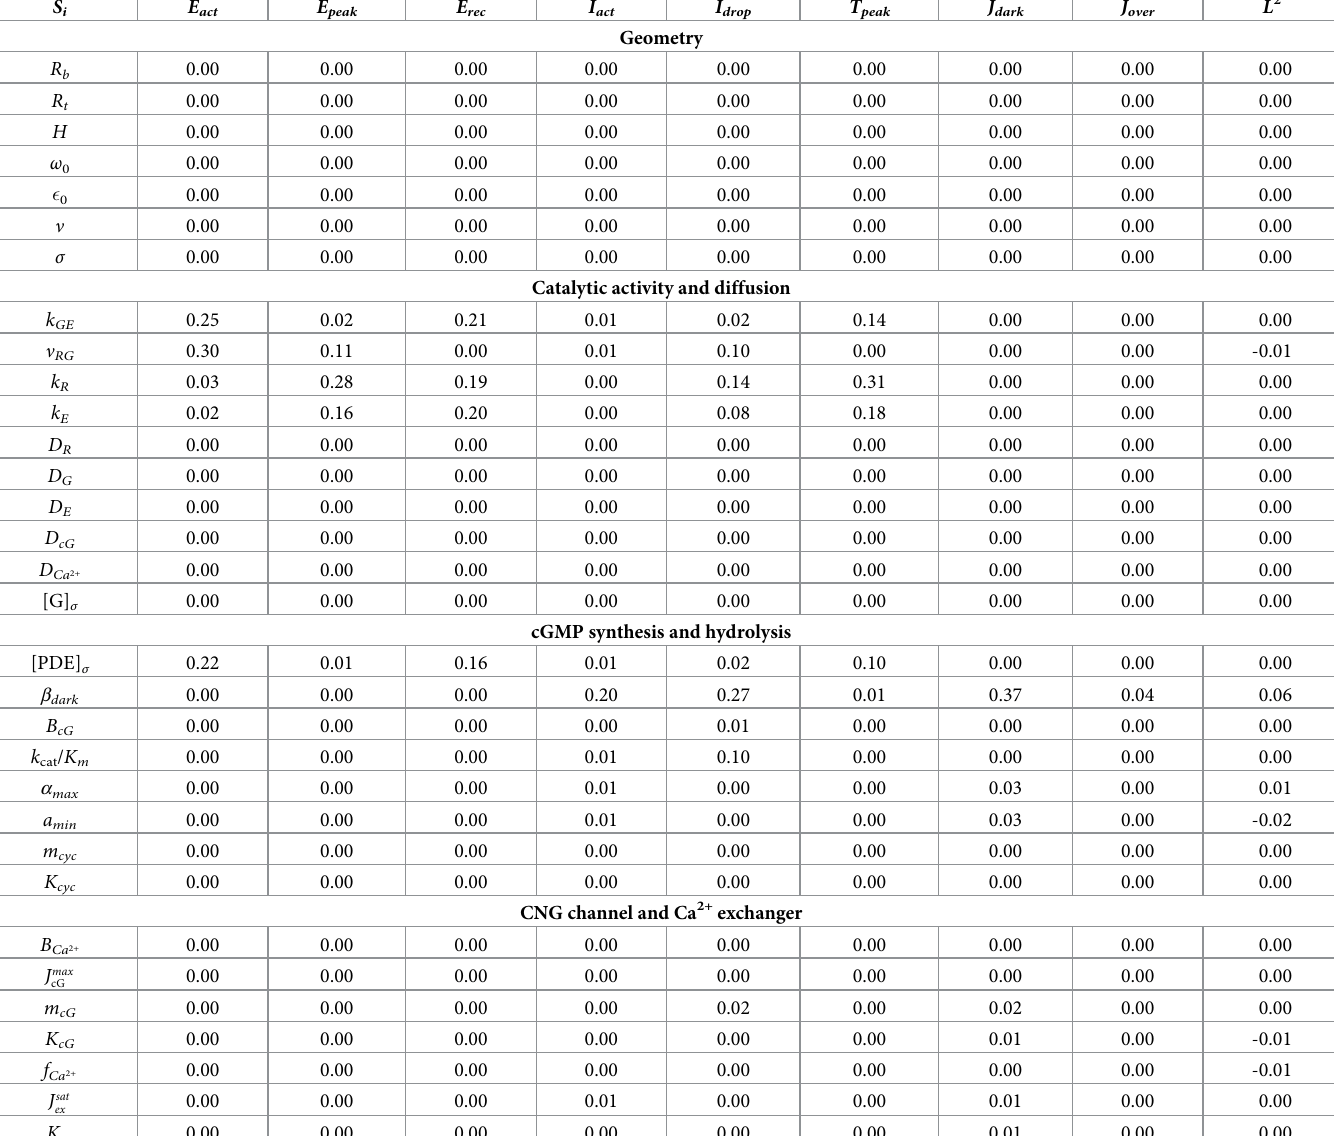
Table 12. Single sensitivity indices. As an index approached 1, the functional became dependent only on that parameter. Most values shown are close to 0, which indi- cated that nonlinear interactions between parameters dominated the cone flash response. While the theoretical value of the Sobol index must fall in the interval [0, 1], small negative values sometimes occurred above as an artifact of the Monte Carlo approximation. These should be regarded as approximately 0. Confidence intervals are given in S1